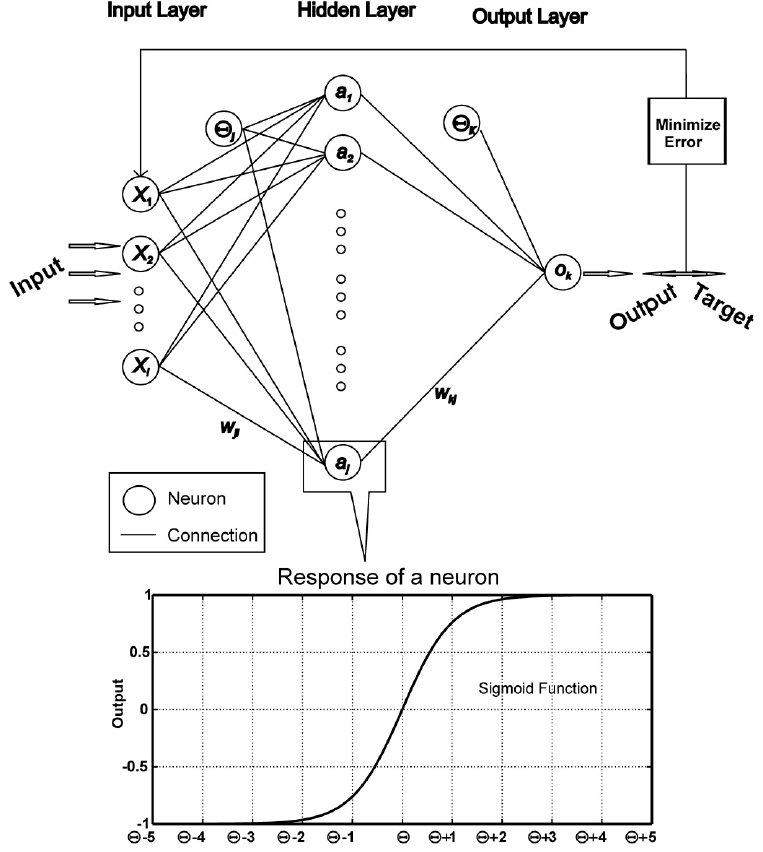
Fig. 2. Schematic diagram of Multi-Layer Perceptron (MLP). Information flows from input to output layer through connection (synaptic weight). Weighted sum is passed through nonlinear activation function. Nodes are interconnected to the nodes at the next